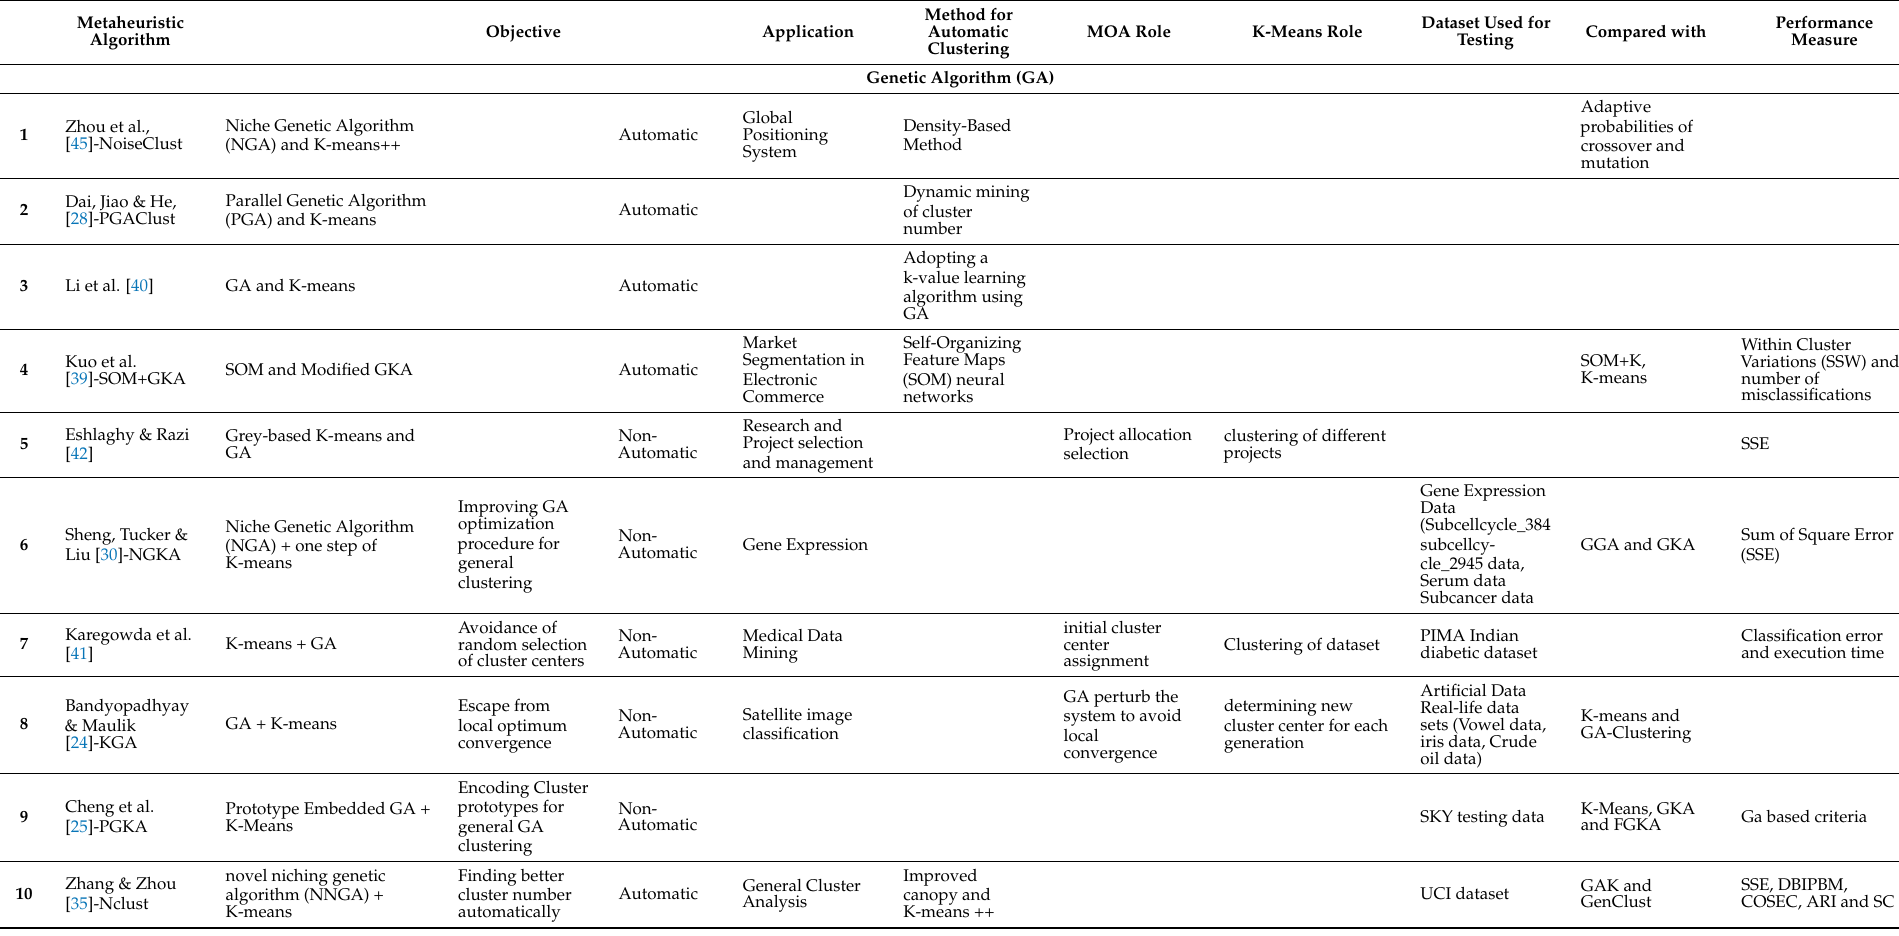
Table 1. List of hybridized algorithms combining K-means algorithm with various